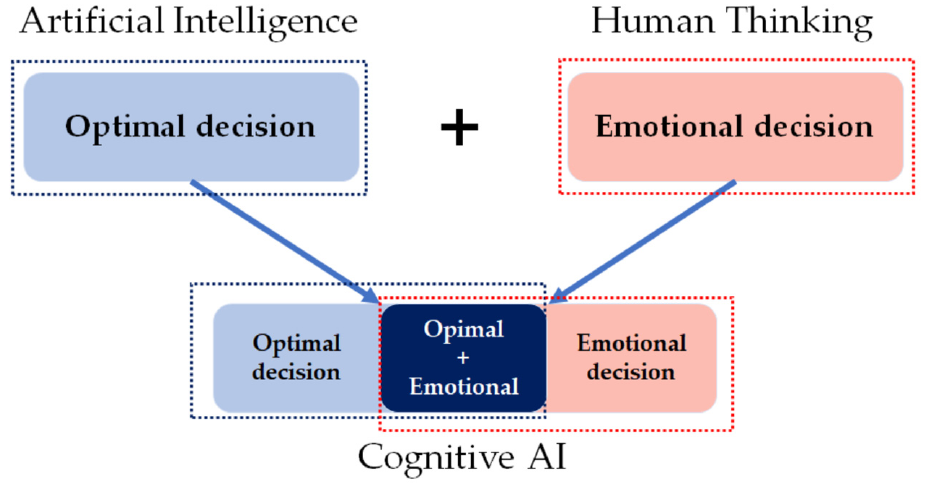
Figure 2. Our cognitive AI structure.